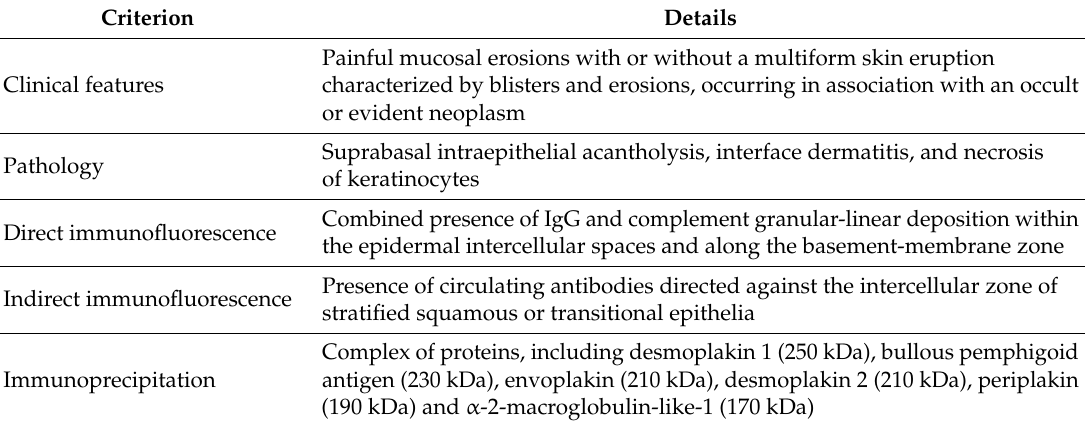
Table 4. Diagnostic criteria for the diagnosis of paraneoplastic pemphigus (adapted from [7]). Criterion